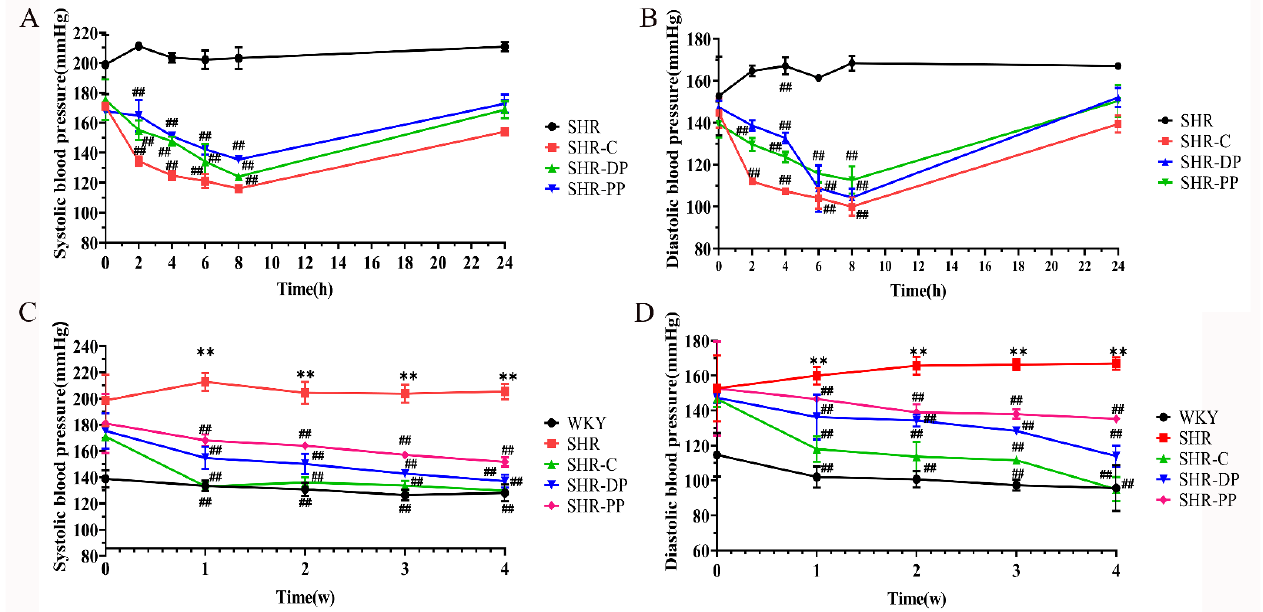
Figure 1. Changes of blood pressure of all rats after single and long-term drug intervention. ( A , B ) SBP and DBP of rats in each group after the single drug intervention; ( C , D ) SBP and DBP of rats in each group after the long-term drug intervention. The data in the figure are expressed as mean ± SEM. ** p < 0.01, represents the difference from the WKY group, respectively; ## p < 0.01, represents the difference from the SHR group, respectively.